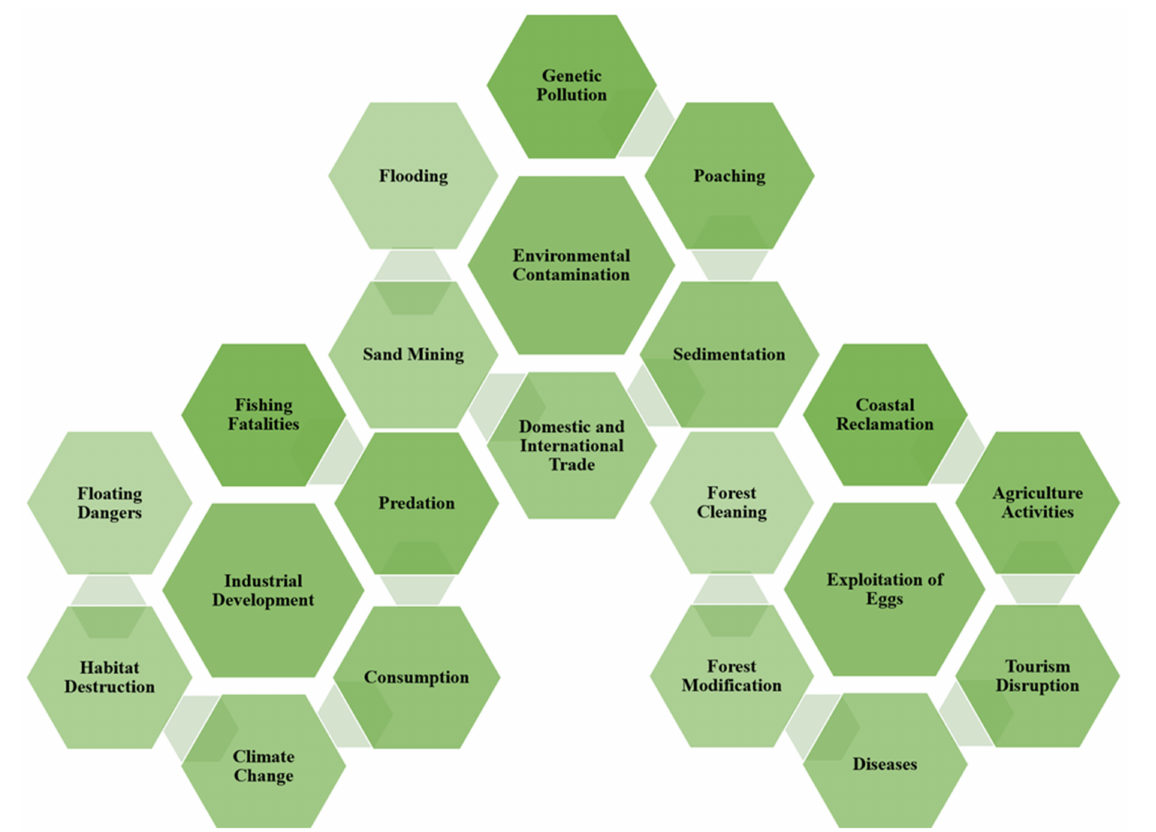
Figure 5. These threat factors were compiled from IUCN data, the DOF Report, DWNP Report, TRAF- FIC South-east Asia Report, species-recovery plans, federal-agency re-sponses, and miscellaneous publica-tions on species’ life history. A complete list of documents used to assign biological attributes to endangered species is available from the authors.